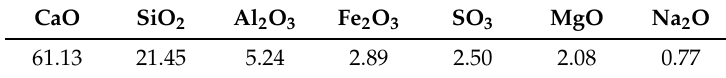
Table 3. Chemical composition of the cement.